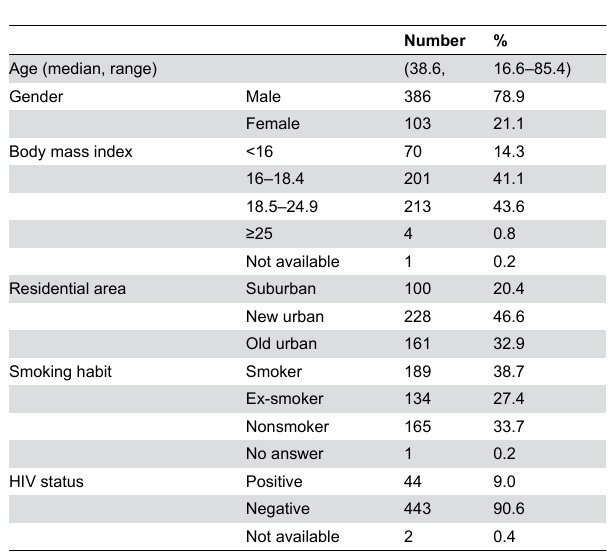
Table 2. Patterns of INH, SM, RMP, and EMB resistance ( n =